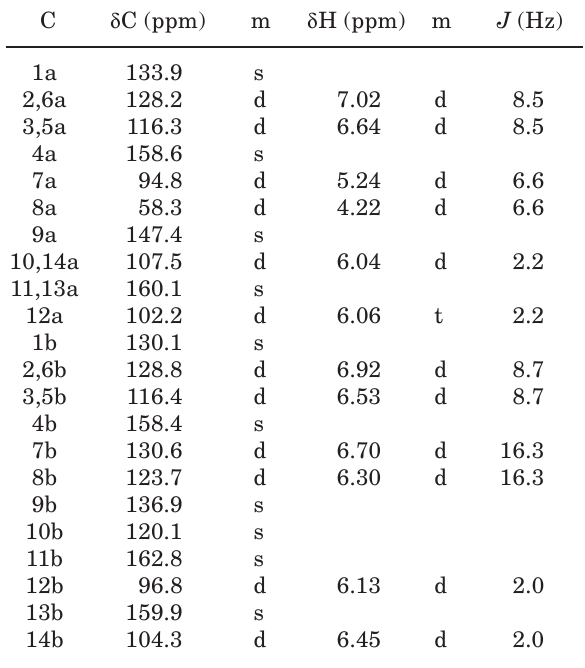
Table 3. 13 C and 1 H NMR data of e